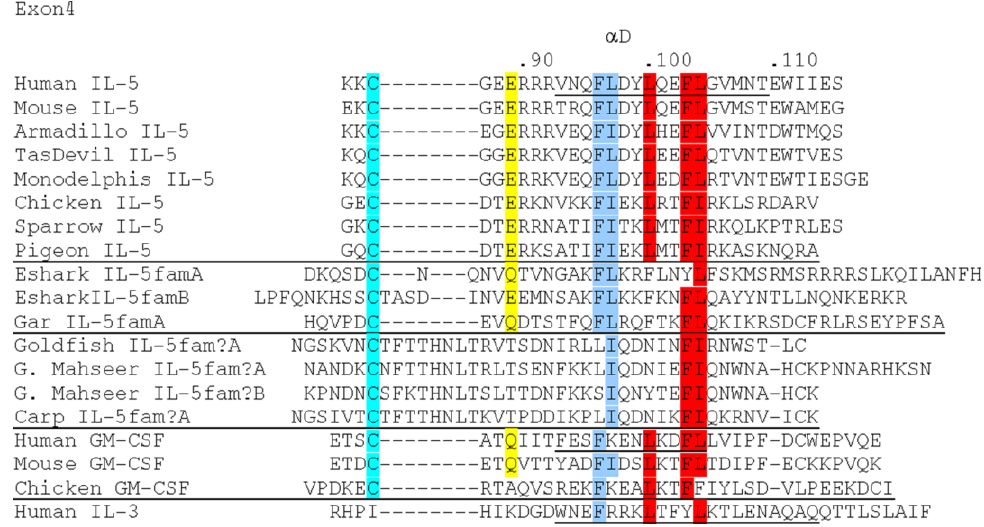
Figure 3. Alignment of (deduced) IL-3/IL-5/GM-CSF family member amino acid sequences. (Predicted) leader peptides are indicated with gray shading; for predictions SignalP software was used (http://www.cbs.dtu.dk/services/SignalP/). The alignment is organized